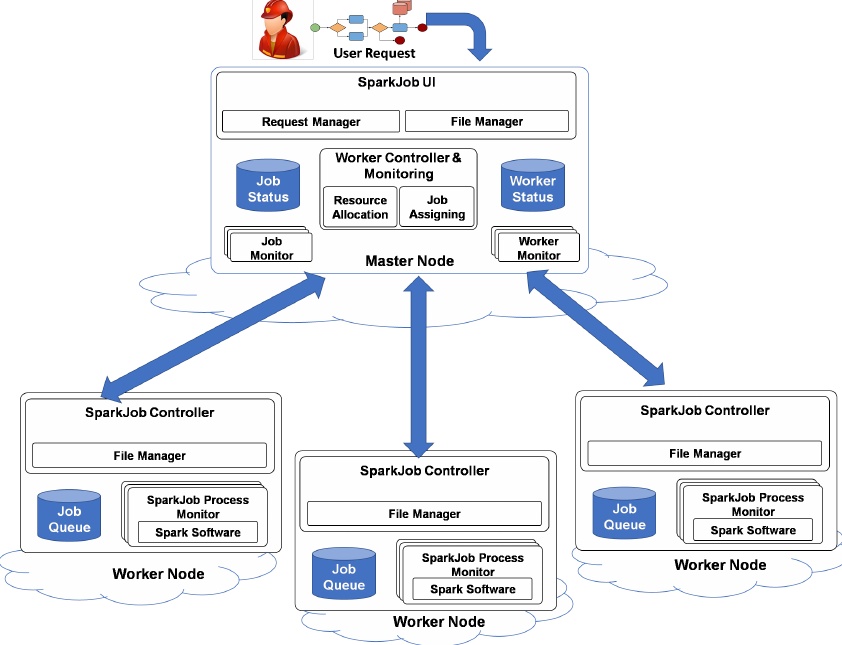
Figure 1. SparkCloud architectural components for master node and worker nodes. Master node manages user request allocations to different workers, which manage the execution of the simulation model on the basis of the